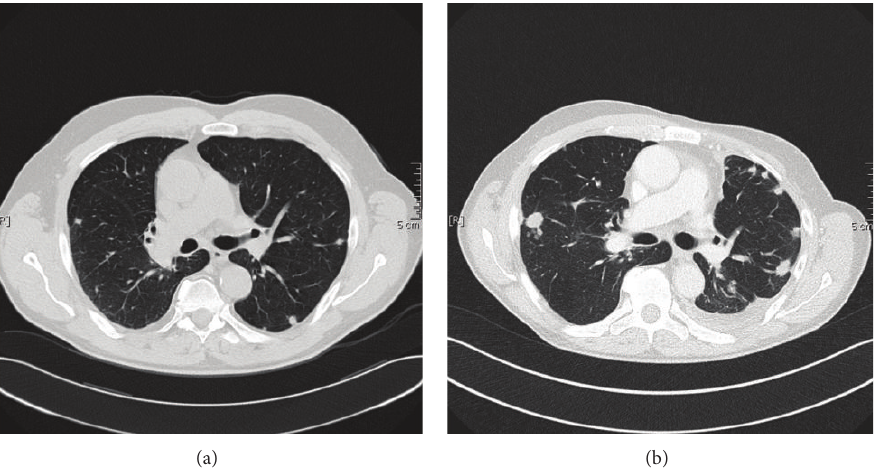
Figure 3: CT scan before the palliative chemotherapy with docetaxel and gemcitabine (a); the reevaluation CT scan (b) showed clear bilateral pulmonary progression after multiple cycles of palliative chemotherapies.